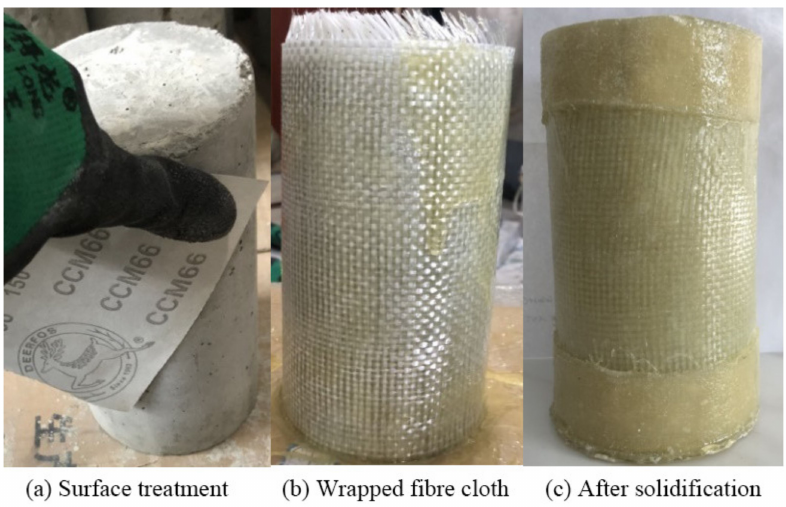
Figure 2. Fabrication process of composite-confined concrete short column.